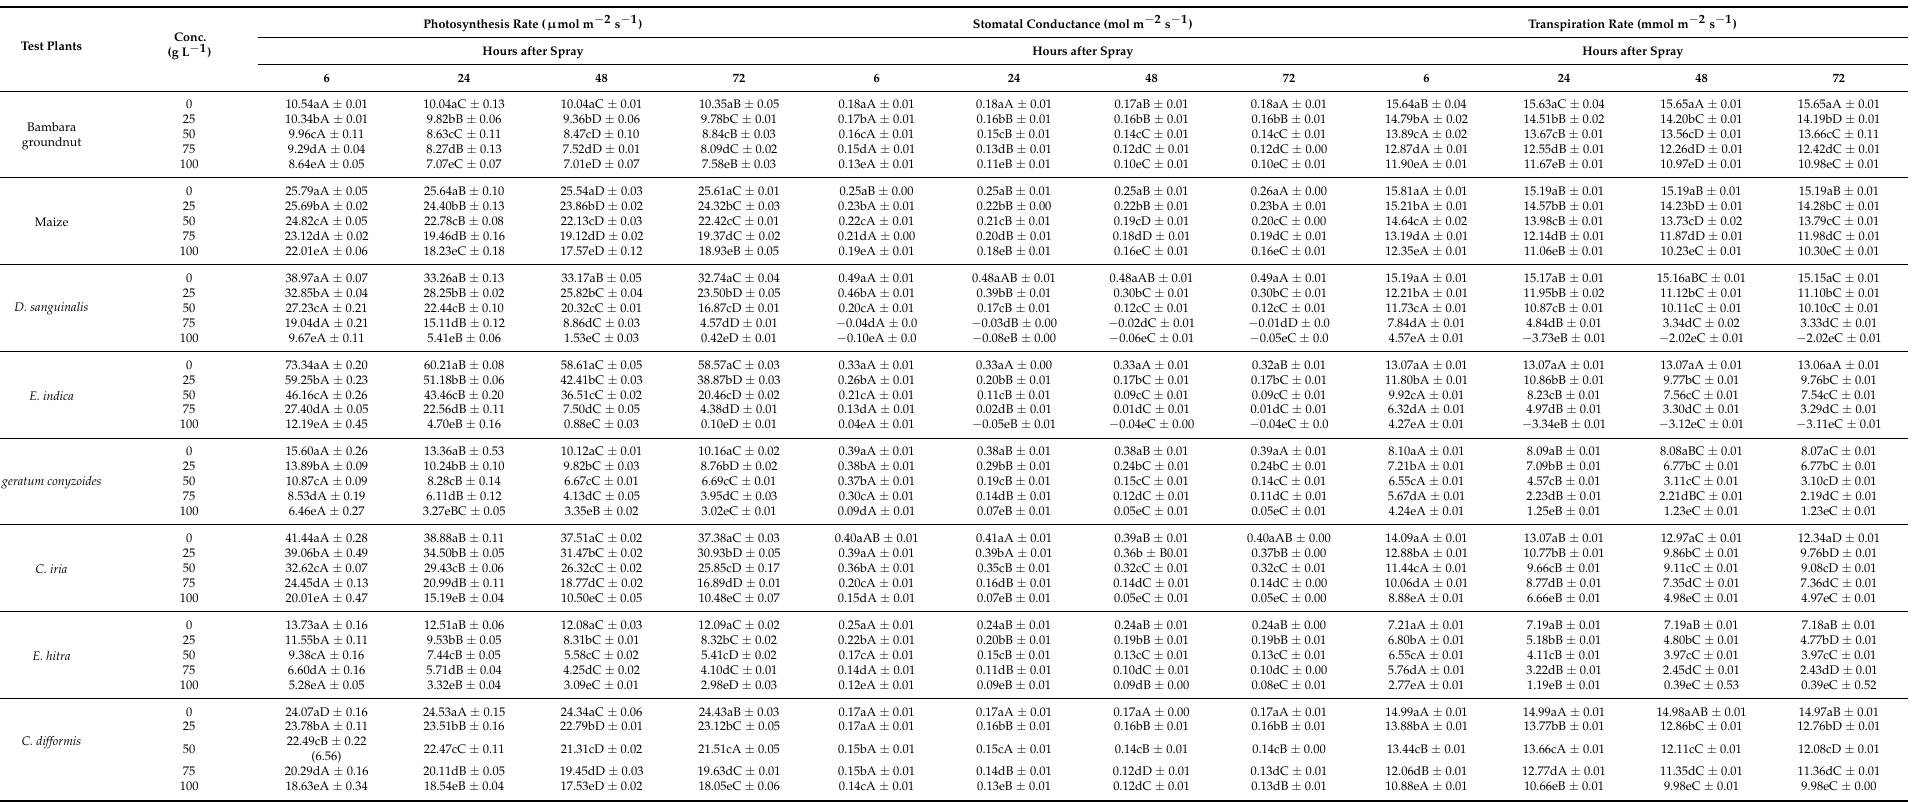
Table 5. Response of photosynthesis rate, stomatal conductance, and transpiration rate due to the foliar spray of P. hysterophorus leaf extracts on several crops and